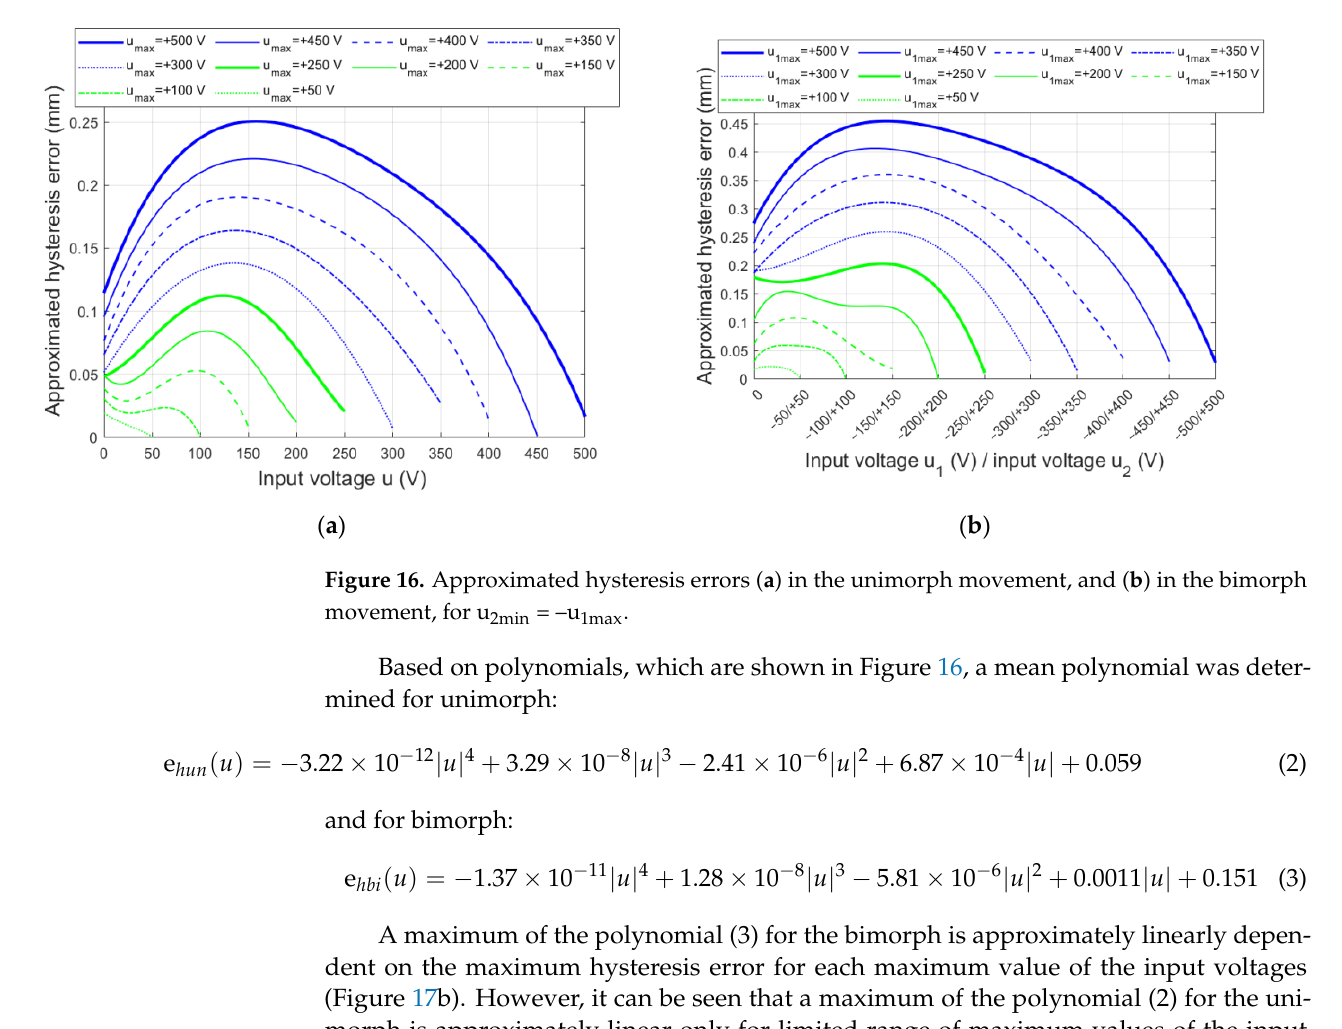
Figure 15. Selected results of the regression analysis for bimorph, u 1max = +500 V, u 2max = –500 V; and for unimorph, u max = u 1max = +500 V.